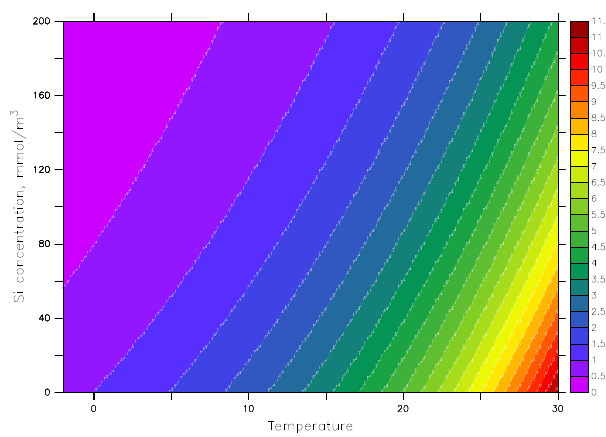
Figure 4. Dissolution rate of PSI ( λ (cid:63) 0 ◦ C with no silicate. Temperature is in ◦